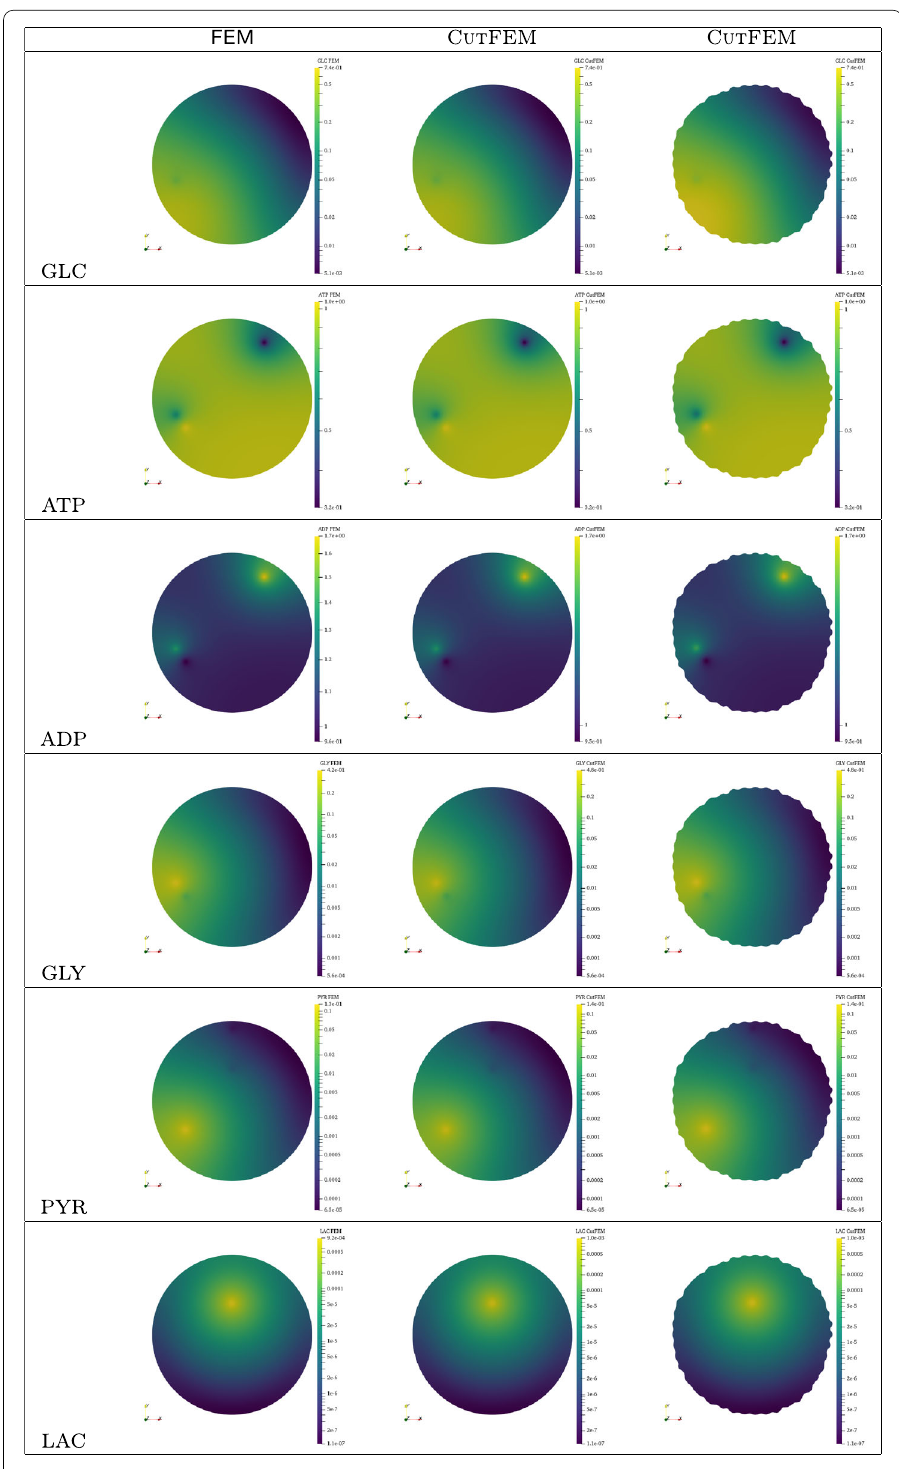
Fig. 7 Solutions of the concentrations, from top to bottom: GLC, ATP, ADP, GLY, PYR and LAC, at time t = 5 in a circular domain solved with FEM (Left), CutFEM (Center) and CutFEM in a perturbed boundary (Right). The source term of GLC is no longer active, and the quantity of GLC is spreading through the domain and participating into the reaction HXK. ATP and ADP show that in the region where HXK, PYRK and act are located, when one is consumed the other is produced. We can notice production of GLY, PYR and LAC. Comparing the results in the three domain, they are extremely close to each other and visually not